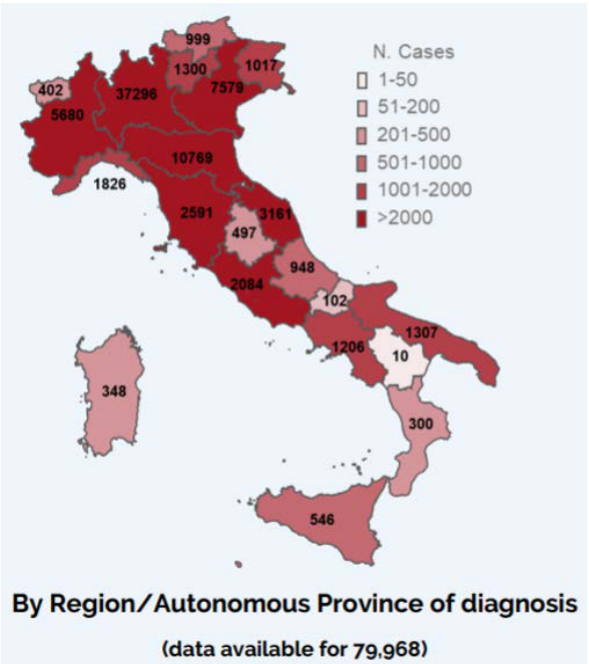
Figure 2. Number of COVID-19 cases diagnosed by Region/Autonomous Province of diagnosis ( N = 79968)—27 March 2020 [15].